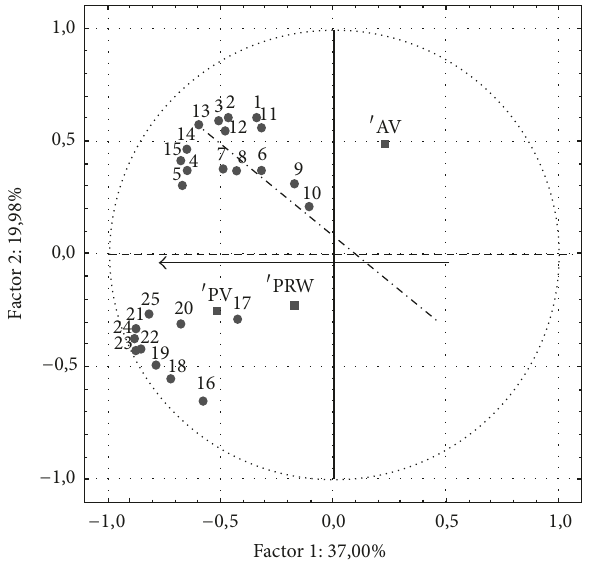
Figure 8: Correspondence analysis for pycnidiospores and ascospores in 1999-2000. Association between PRW, PV, AV, and weather variables as rainfall, relative humidity, radiation, and temperature (3, 7, 15, 30, and 60 days before the sampling